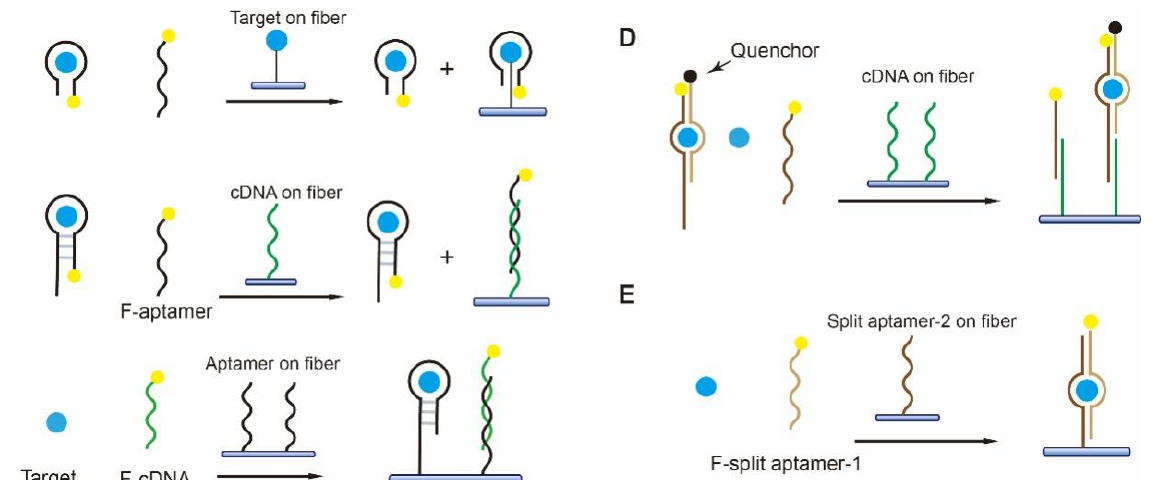
Figure 8. The major progress of FNA-FOEW sensors according to the target scope.